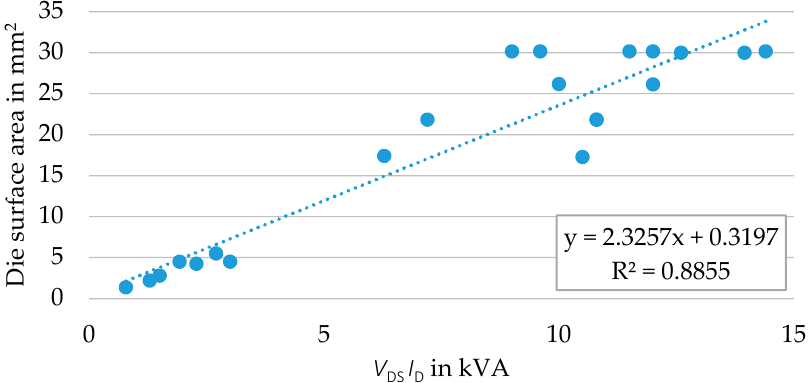
Figure 9. Relation between the product of the drain-to-source voltage V DS multiplied with the drain current I D and the die surface area.